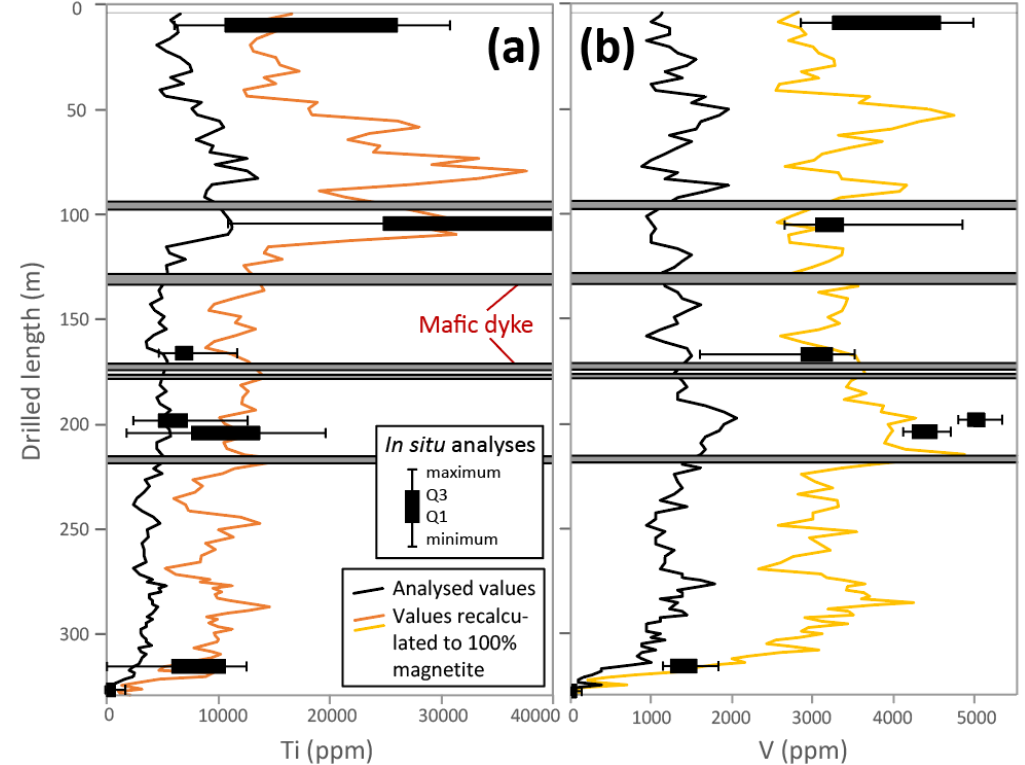
Figure 15. Ti ( a ) and V ( b ) contents (company dataset minus seven mafic dyke samples) represented as a function of downhole length. The V and Ti contents are analyzed bulk rock values (black lines) and values recalculated to 100% magnetite (orange lines). The magnetite proportions used to perform these calculations were measured by SATMAGAN.